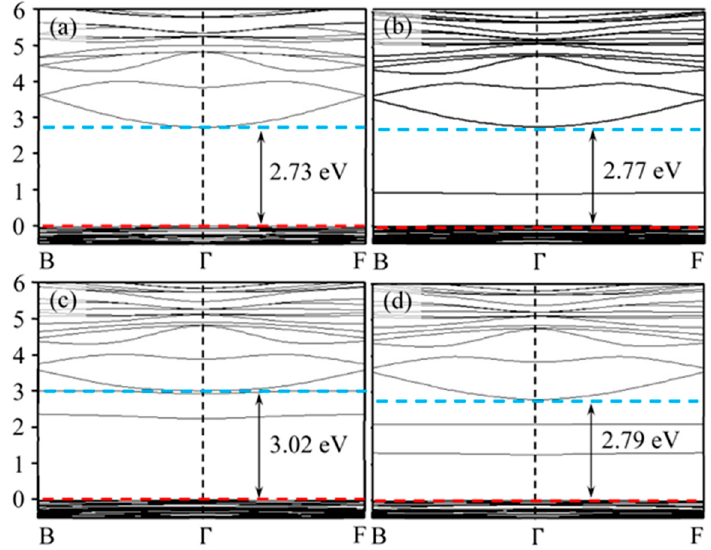
Figure 12. GGA band gaps of ( a ) the oxide-passivation ZGO surface, ( b ) the oxide-passivation ZGO surface with one surface oxygen removed, ( c , d ) NO 2 -like molecules on the oxide-passivation ZGO surface. The blue and red dashed lines represent the conduction band minimum and valence band maximum, respectively.